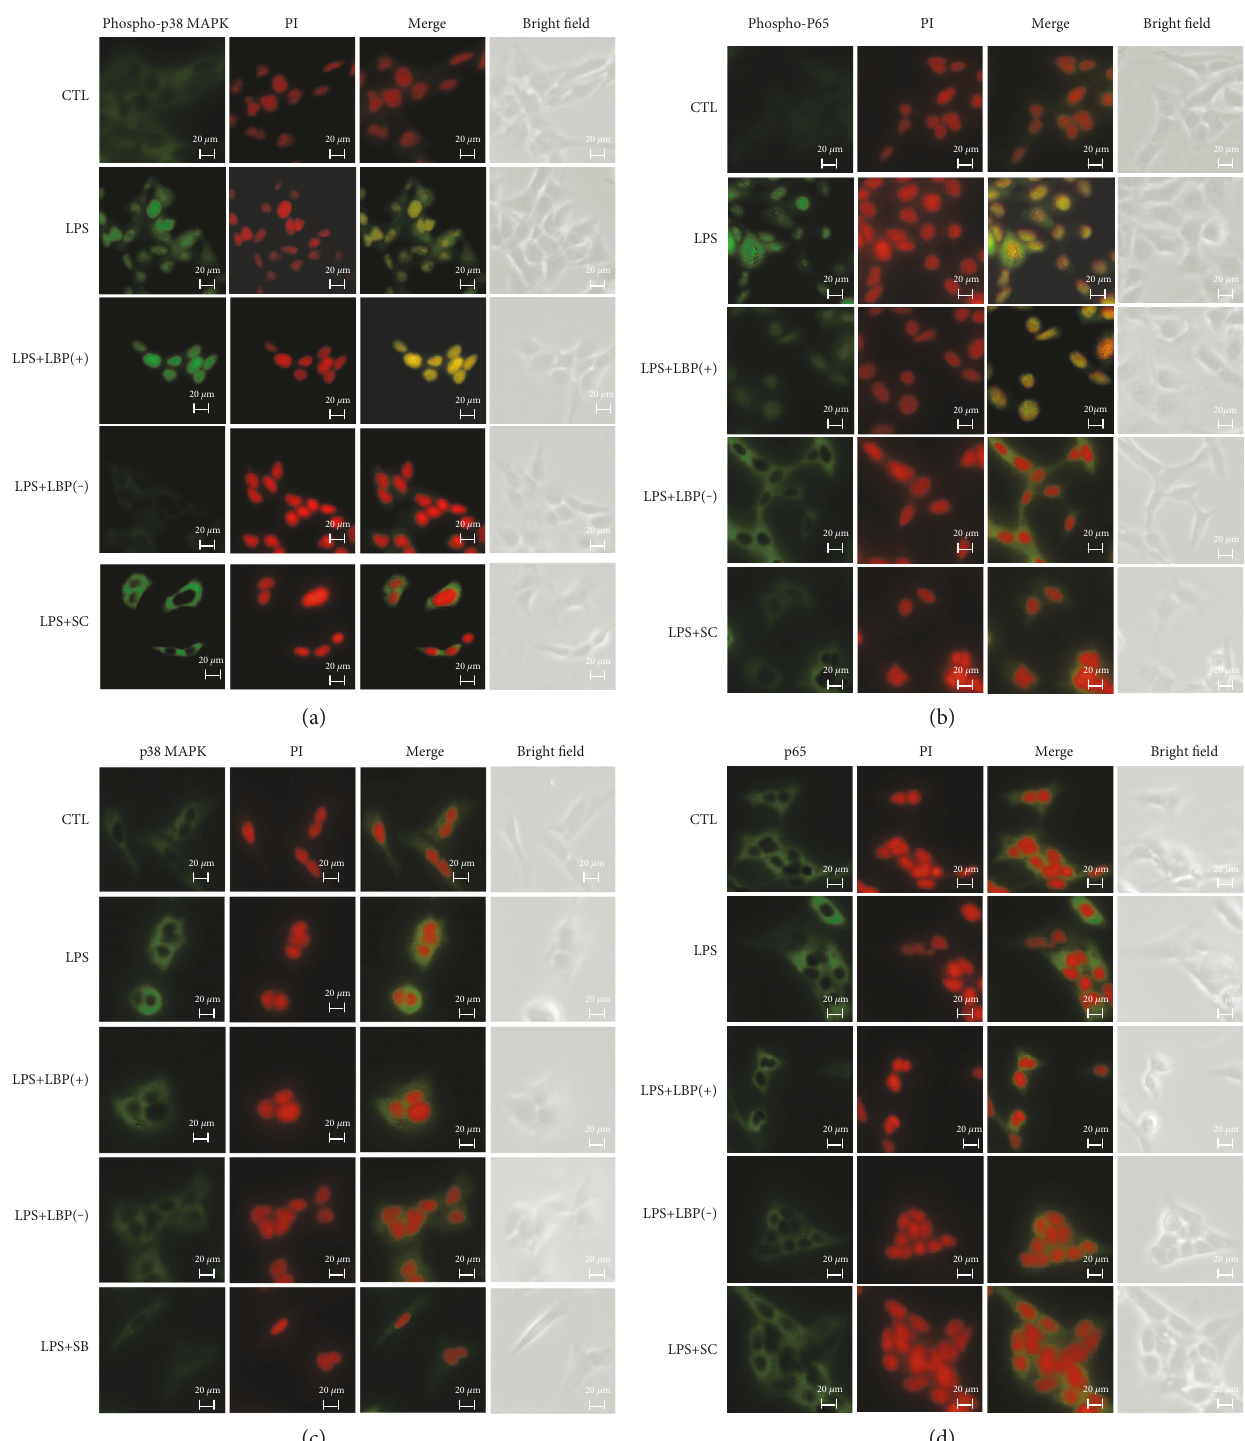
Figure 3: (a) LBP promoted phospho-p38 MAPK translocation, LBP shRNA, and SB203580 inhibited phospho-p38 MAPK translocation in response to LPS stimulation, and (b) LBP promoted phospho-p65 translocation, LBP shRNA, and SC-514 inhibited